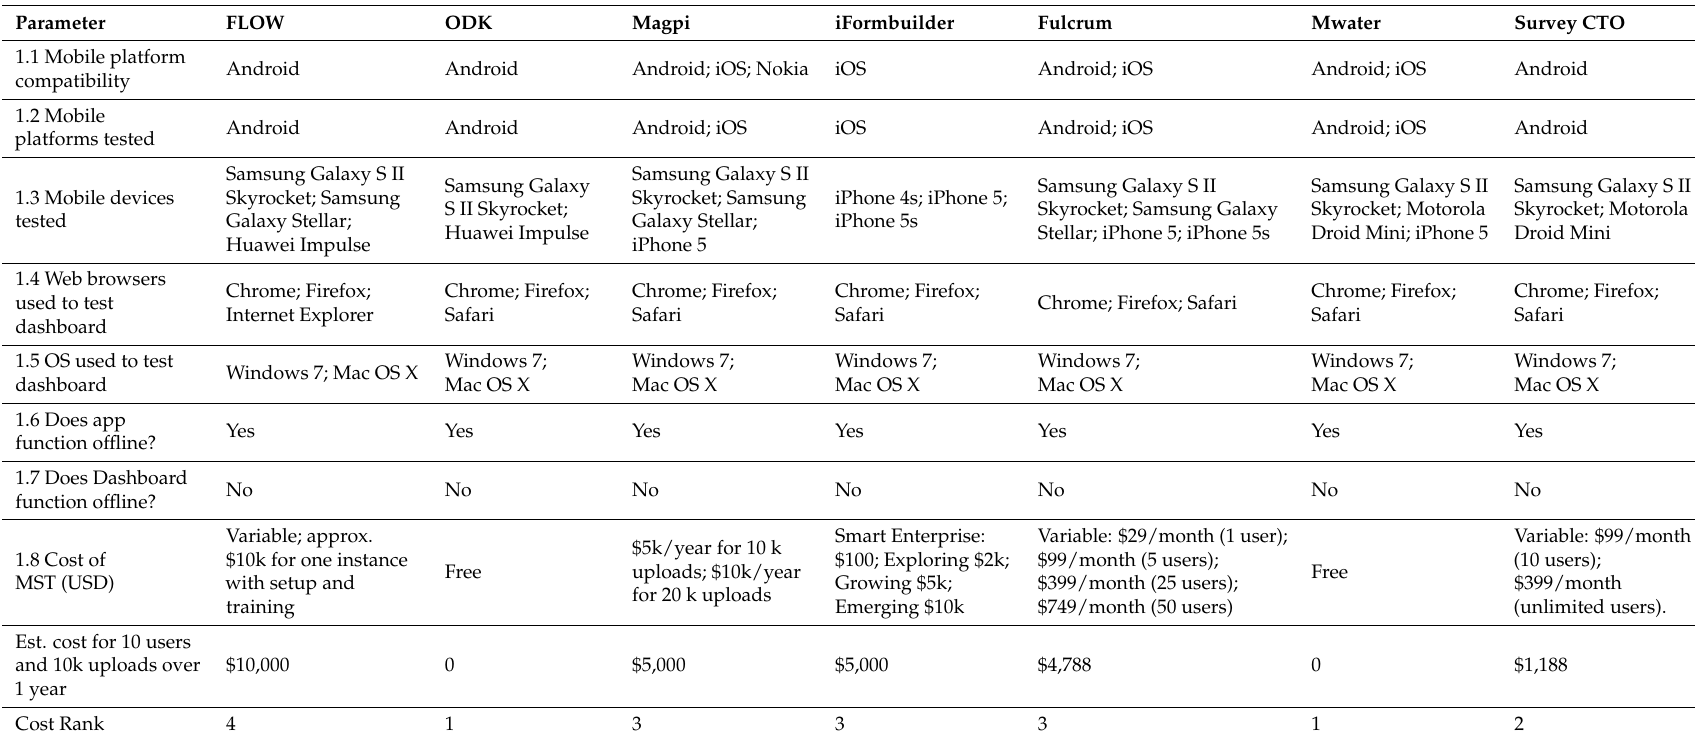
Table 11. General characteristics of MSTs tested (as of